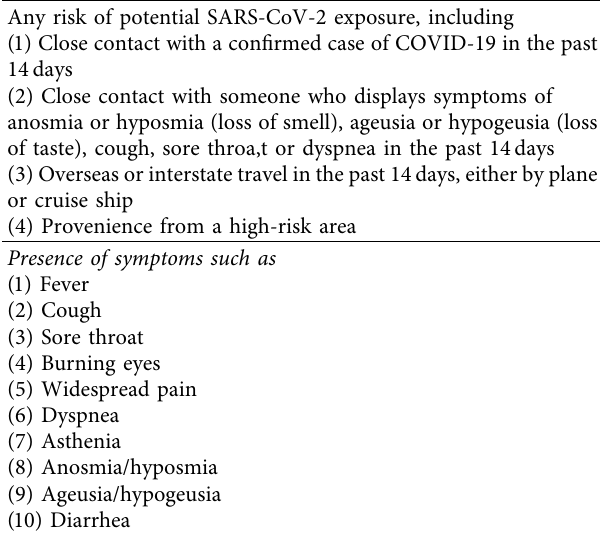
Table 1: COVID-19 anamnestic questionnaire. COVID-19 anamnestic questionnaire Any risk of potential SARS-CoV-2 exposure,